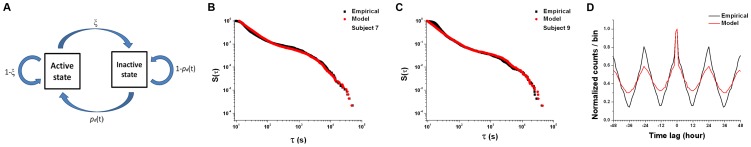
Comparison of the simulation of the dual-state model with the empirical data.(A) Schematic diagram for the dual-state model. (B–C) Cumulative ICI distributions of the empirical data (black squares) from two example rats and the simulated data from the dual-state model (red circles) in a log-log scale. (D) Autocorrelograms of the empirical and the simulated data averaged across rats. The black and red lines denote the empirical and the simulated data, respectively. The time interval between peaks of the simulated data is 24 hours, which is consistent with that of empirical data.